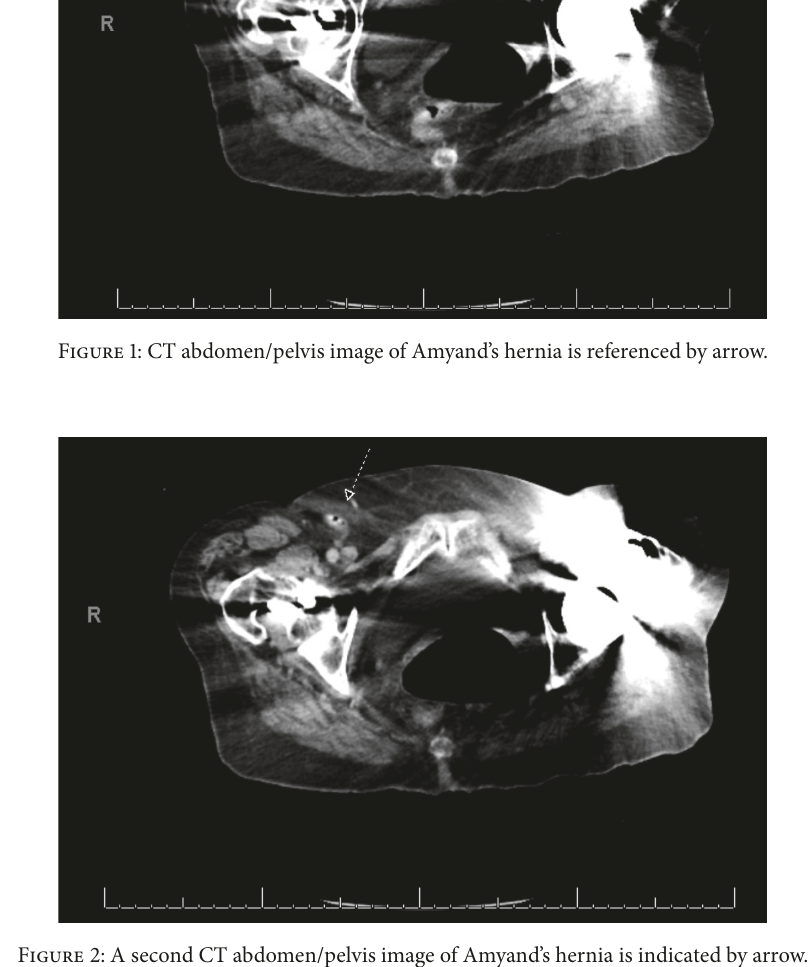
Figure 2: A second CT abdomen/pelvis image of Amyand’s hernia is indicated by